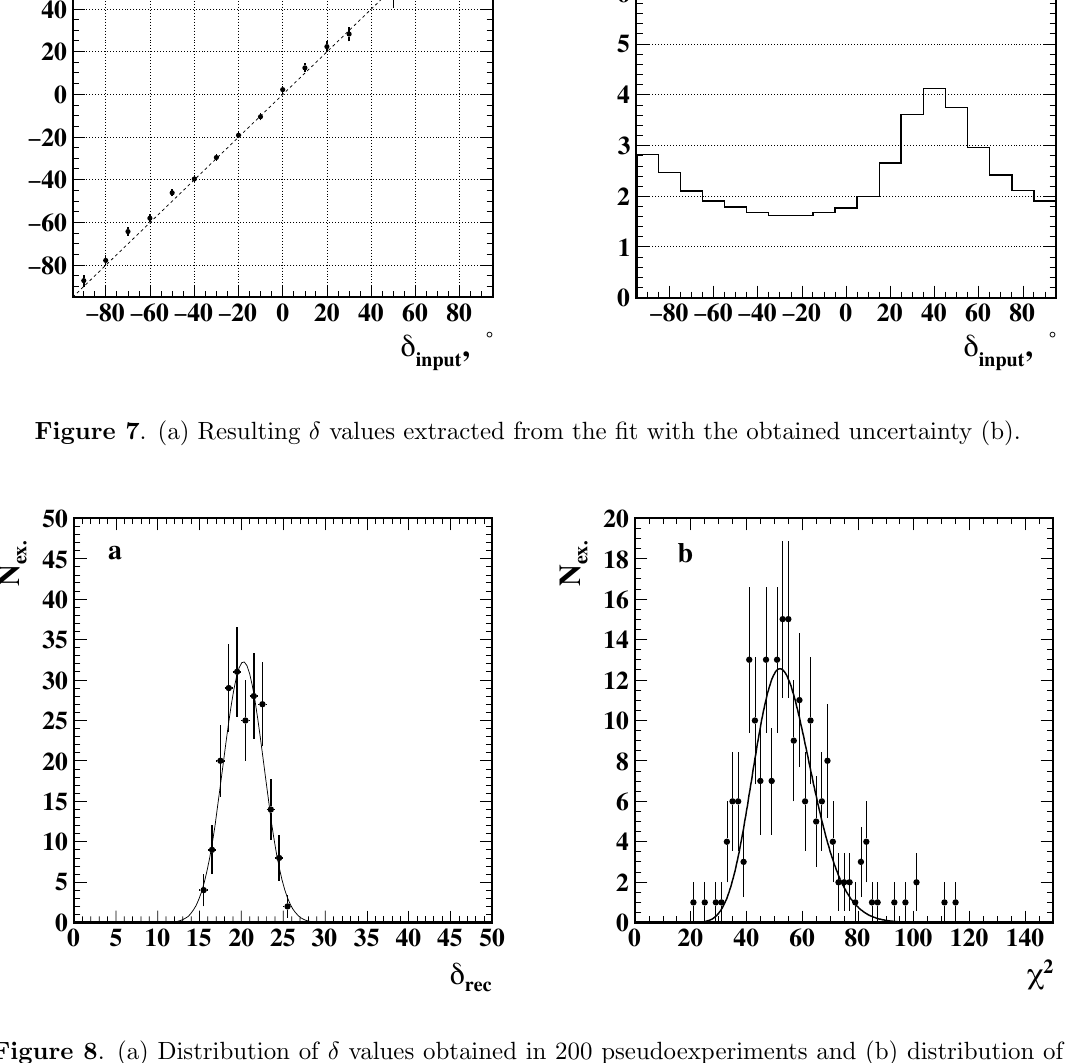
Figure 8 . (a) Distribution of (cid:14) values obtained in 200 pseudoexperiments and (b) distribution of chi-square values. The solid lines are (cid:12)t results with Gaussian and chi-square distribution functions,